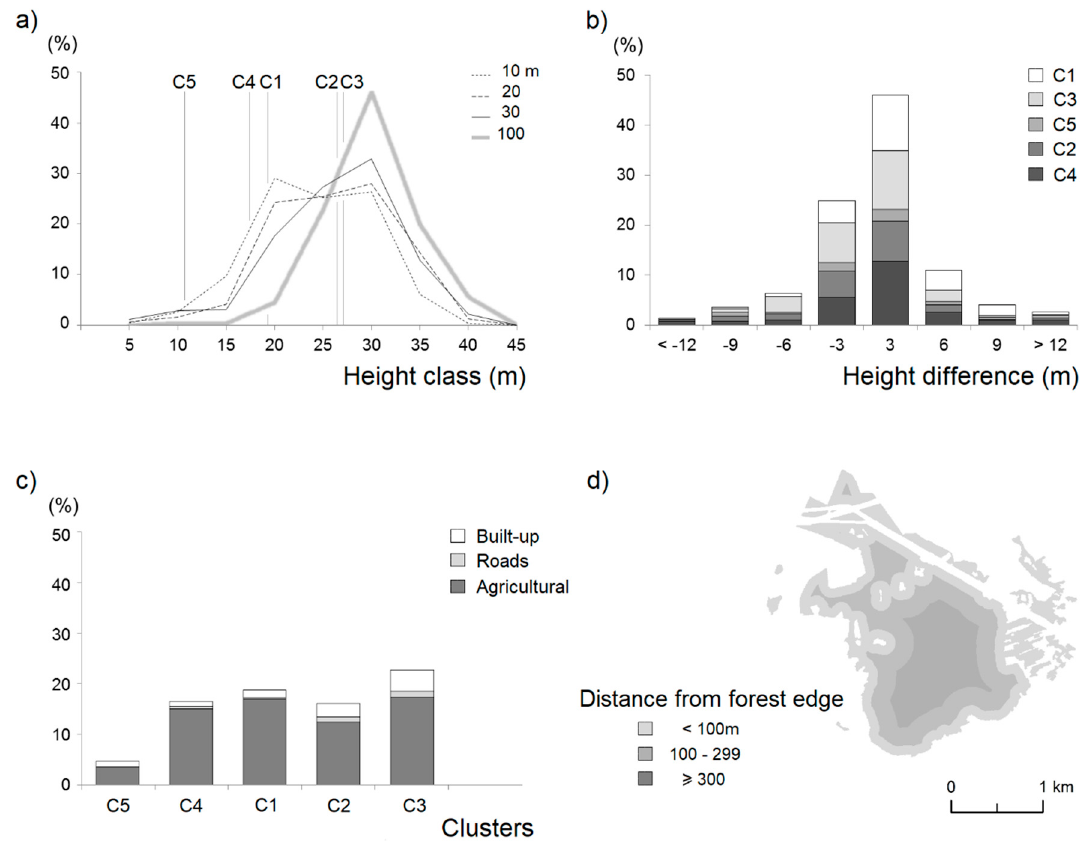
Figure 7. The proportion of canopy cover at di ff erent height levels of trees ( a ); height di ff erences between the tallest trees in the first and second forest edge belts ( b ); and lands bordering on the forest edge ( c ); in the area of the Nadgorica forest patch ( d ).